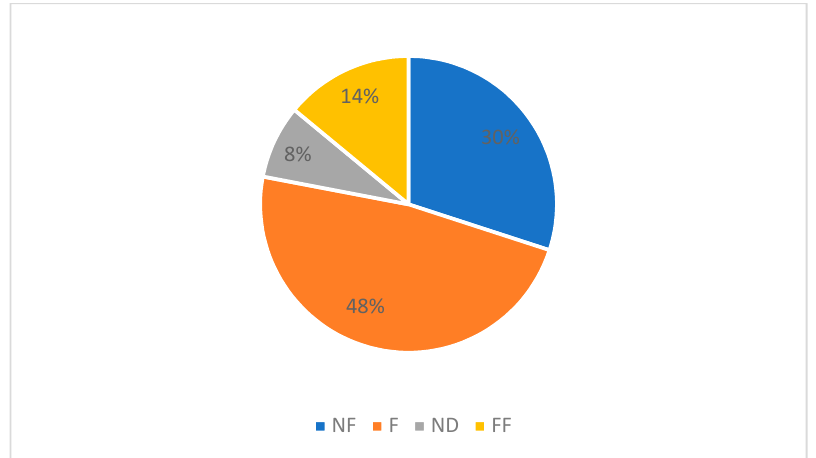
Figure 10. Results of the experiments in the afternoon for the evening circadian chrono-type.